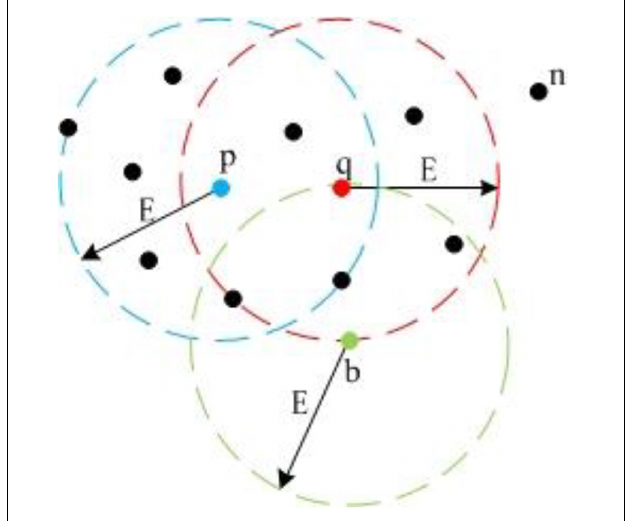
FIGURE 6 | Different point types in DBSCAN. Because p and q both have more than five neighbors within E circle adjacent area, they are Core Points; b has less than five neighbors, but it lies in the adjacent area of q , so b is a Border Point; n is a Noise Point.